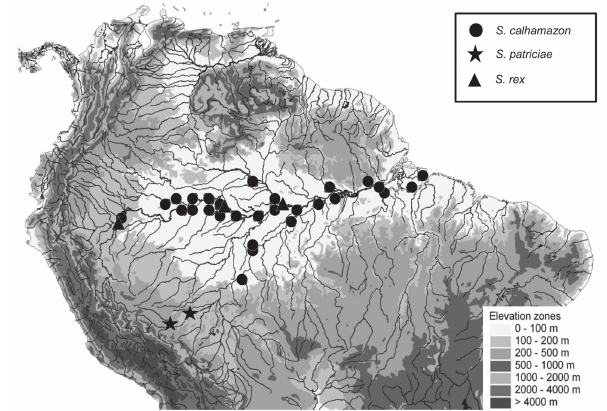
Fig. 8. Map of collection localities of species in the S. calhamazon species group. Sternarchella rex (triangles), S .